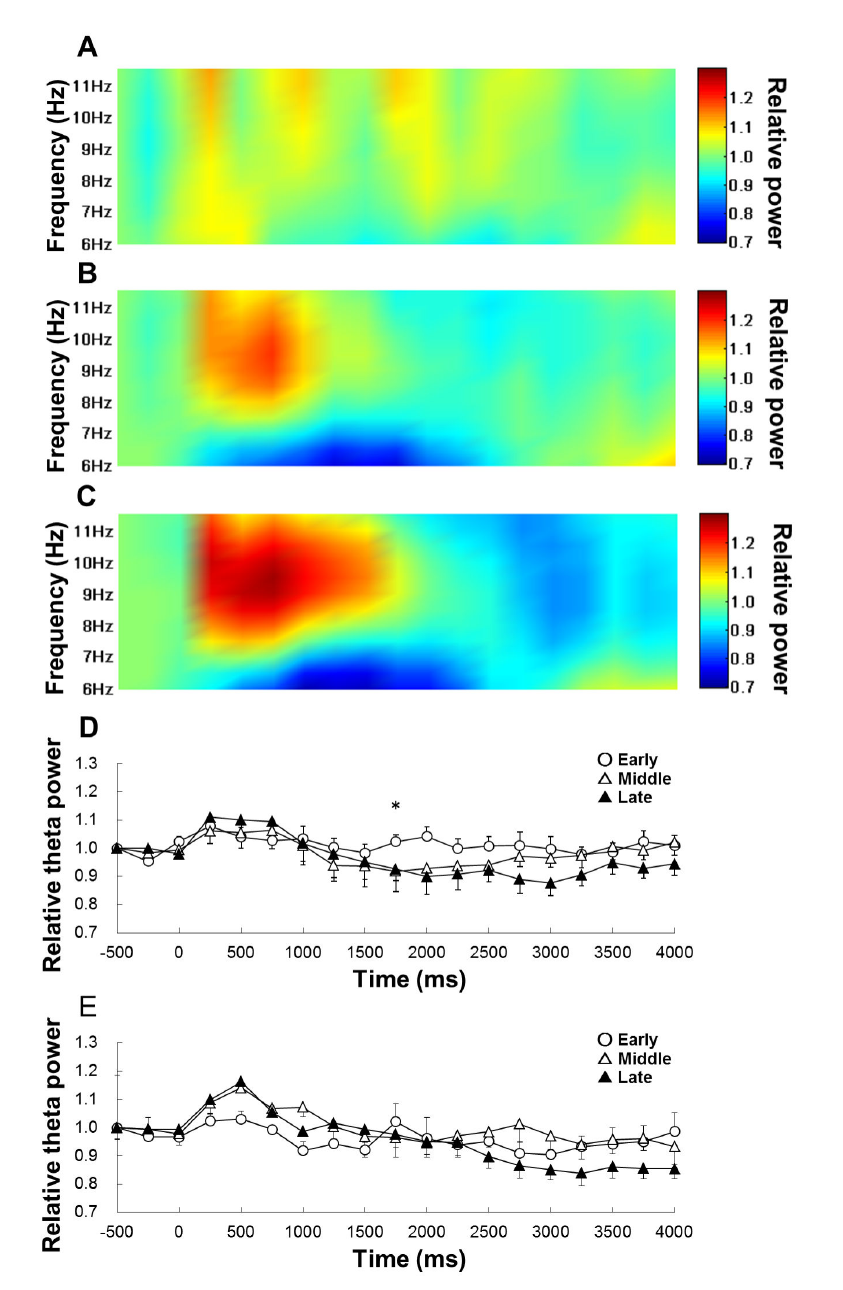
Figure 4. The change in theta power during the RFTs duringeach learning stage of the negative patterning task. Panel A shows the change in hippocampal theta activity along a time course during RFTs on the early stage, panel B shows theta activity on the middle stage and panel C shows theta activity on late stage of negative patterning task. The x-axis is time (ms) and the y-axis is frequency (Hz). In each panel, the period is from 500 ms before stimulus onset to 4000 ms after stimulus onset. The period was divided into 19 sub-periods of 250 ms each. The mean hippocampal theta power during 500 ms before stimulus onset was counted as the -500-ms period (no stimuli were present and no rats pressed the lever during this period) and the relative theta power calculated for each period was normalized to that during the -500-ms period (relative theta activity of each period = theta power of each period/theta power at the -500-ms period). Panel D contains a comparison of the mean (± S.E.M.) relative hippocampal theta activity at 6–12 Hz among each learning stage (early, middle, and late) throughout the time course of the experiment during RFT of the negative patterning task. Panel E contains a comparison of the mean (± S.E.M.) relative hippocampal theta activity at 6–12 Hz among each learning stage (early, middle, and late) throughout the time course of the experiment during RFT of the simple discrimination task. doi: 10.1371/journal.pone.0070756.g004 PLOS ONE |